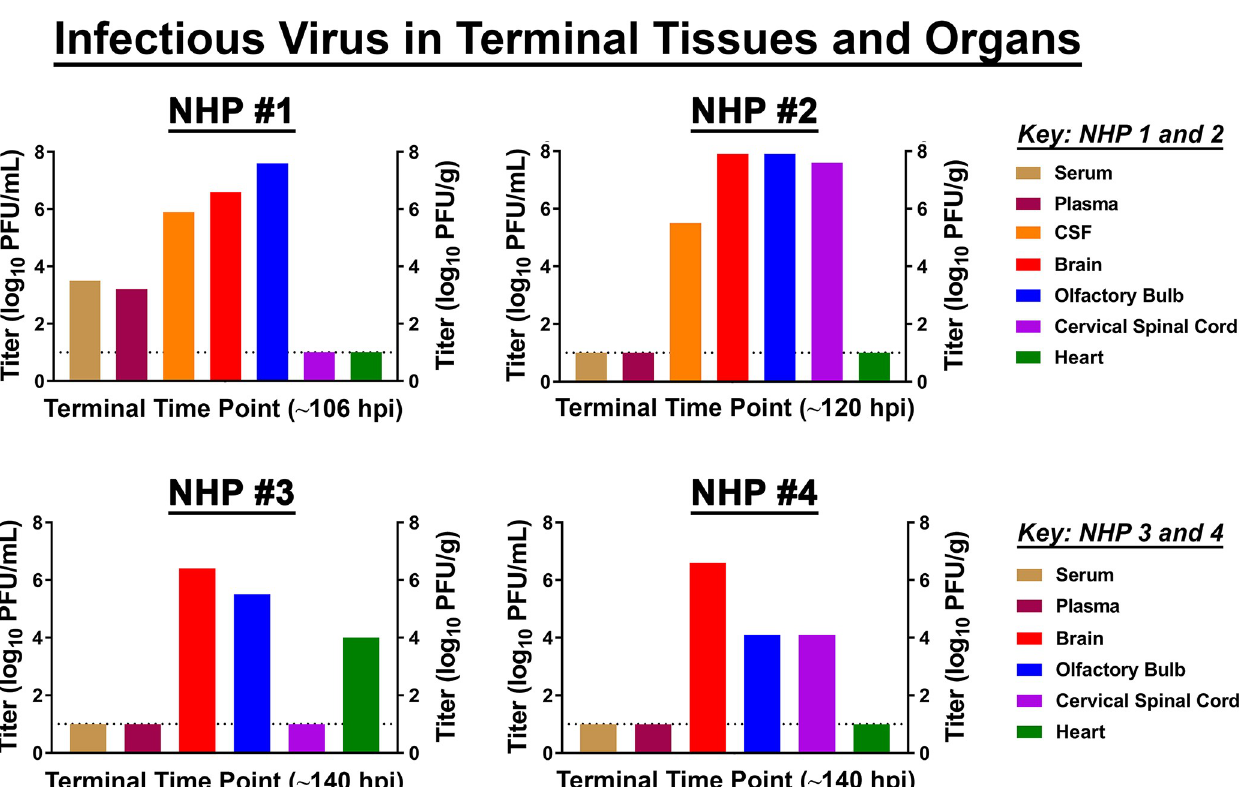
Fig 3. Quantitation of infectious EEEV in NHP tissues collected at the time of euthanasia. The time of tissue collection for each NHP is provided in the x-axis. Limit of detection of plaque assay is 1.0 log 10 PFU/mL or 1.0 log 10 PFU/g and are indicated by a dashed line.